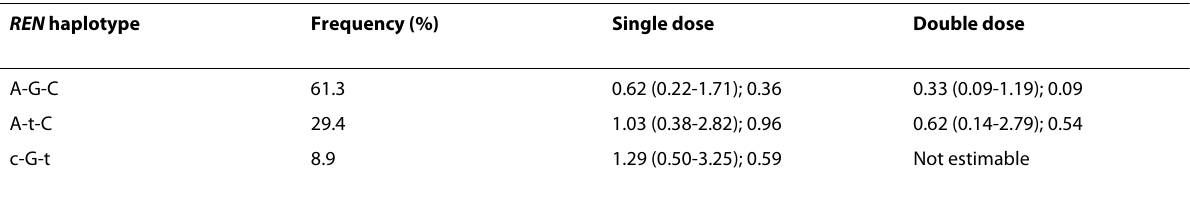
B: Relative risk estimates (95% CI; p-value) for fetal REN haplotypes when mothers do not carry the protective AGT haplotype C-T-A (n = 27